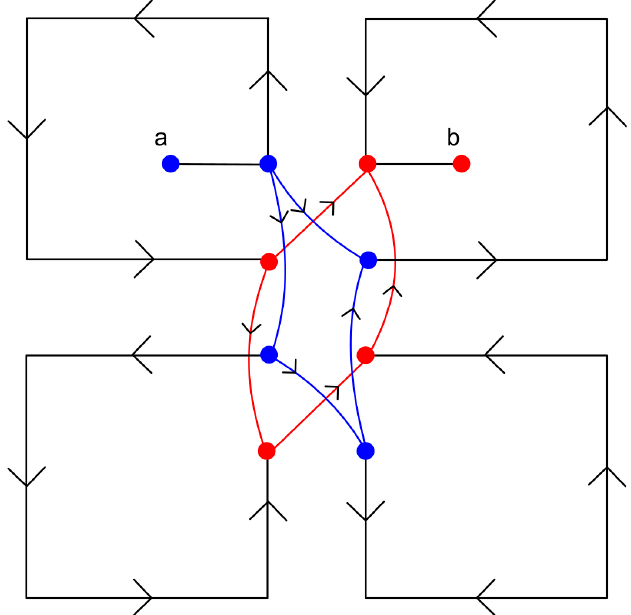
Figure 6. Crossed parallel sub ‐ loop inductors with current flow directions from node a to node b. Sensors 2021 , 21 , x FOR PEER REVIEW